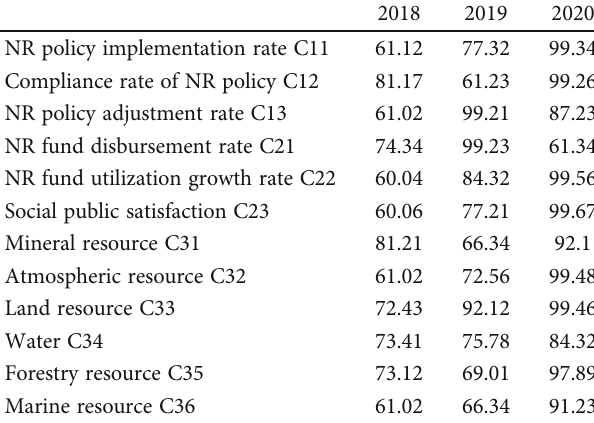
Table 2: The importance of two-element scale. Factor i vs. factor j